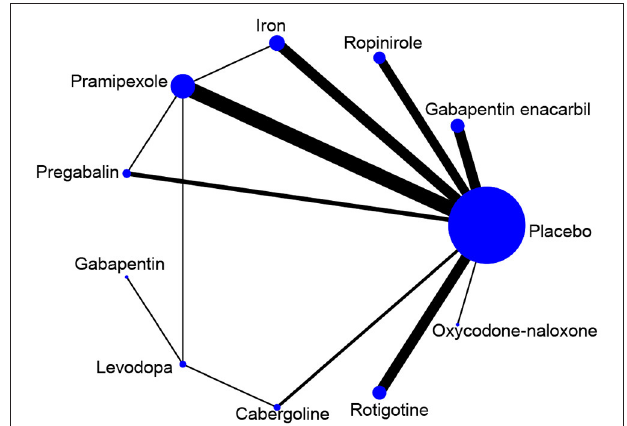
FIGURE 2 | Network map of available comparisons. Width of lines is proportional to the number of trials including every pair of treatments (direct comparisons). Size of every circle size is proportional to the total number of randomly assigned participants (i.e., sample